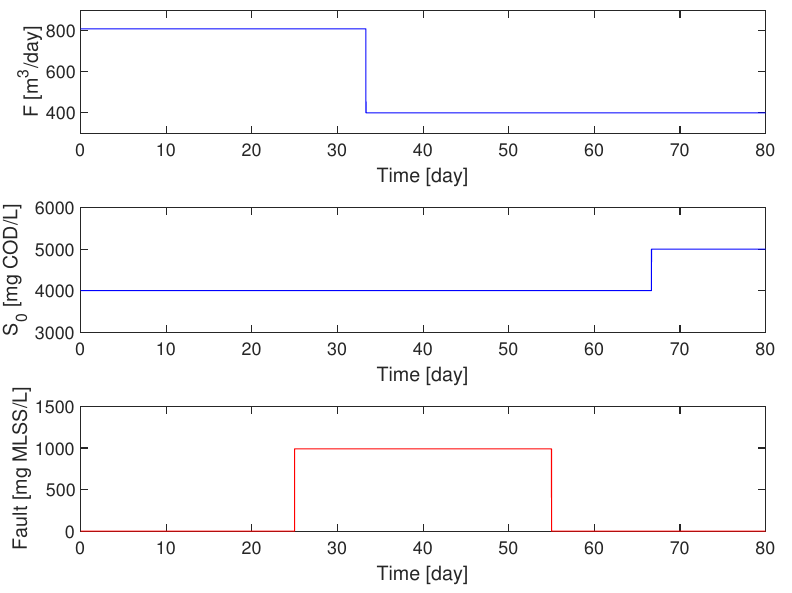
Figure 10. Operation with a fault: setpoint changes and the fault. The fault refers to the case of a 15% fault which is 990 mg MLSS/L. T =